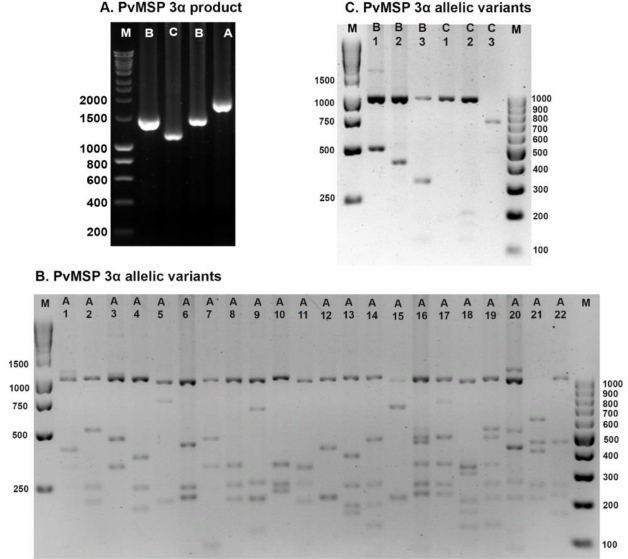
Figure 2. PCR product size variations and allelic variants of PvMSP-3 α . Gel images depict: ( A ) PCR product size variations; ( B ) allelic variants for type A; and ( C ) allelic variants for types B and C. M: Molecular markers (100 bp and 1000